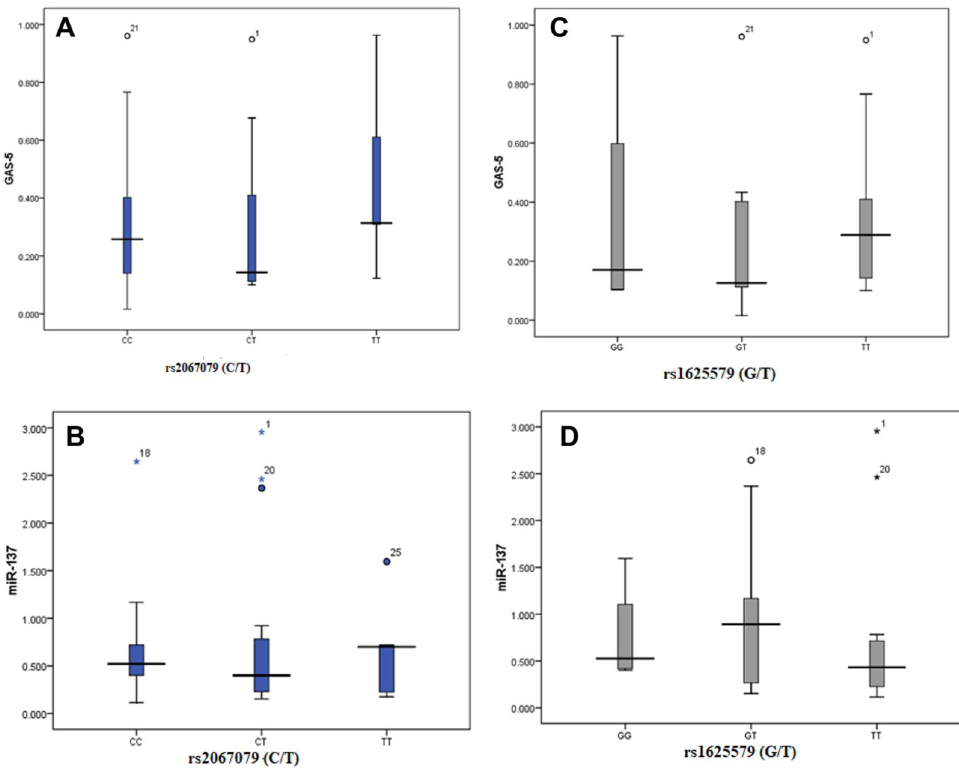
Figure 3. Relation of rs2067079 and rs1625579 genotypes and serum expression levels of GAS5 and miR-137 in chronic viral hepatitis B cases. The box displays the 25% − 75% percentiles; the median is represented by the line inside the box and the upper and lower lines represent the 10% to 90% percentiles of the serum level (fold change) (a) GAS5 in different rs2067079 genotypes and (b) miR-137 in different rs2067079 genotypes; CC (N = 39), CT (N = 57), TT (N = 21) and serum (c) miR-137 in different rs1625579 genotypes (d) and GAS5 in different rs1625579 genotypes; GG (n = 12), GT (n = 27), TT (n =